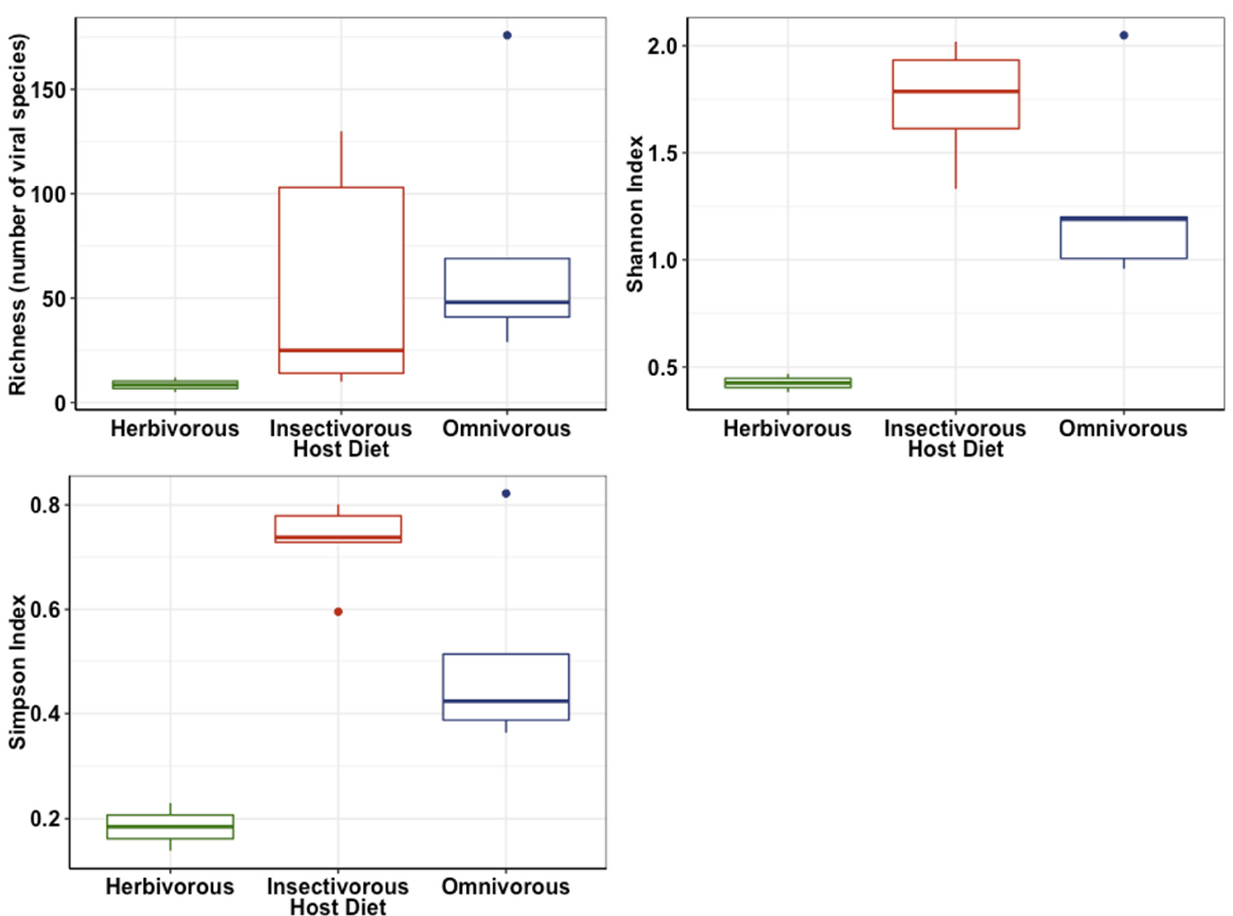
Figure 3. Boxplots showing the differences in Richness (number of viral species) ( top left ), Shannon index ( top right ) and Simpson index ( bottom left ) between hosts with different diets.